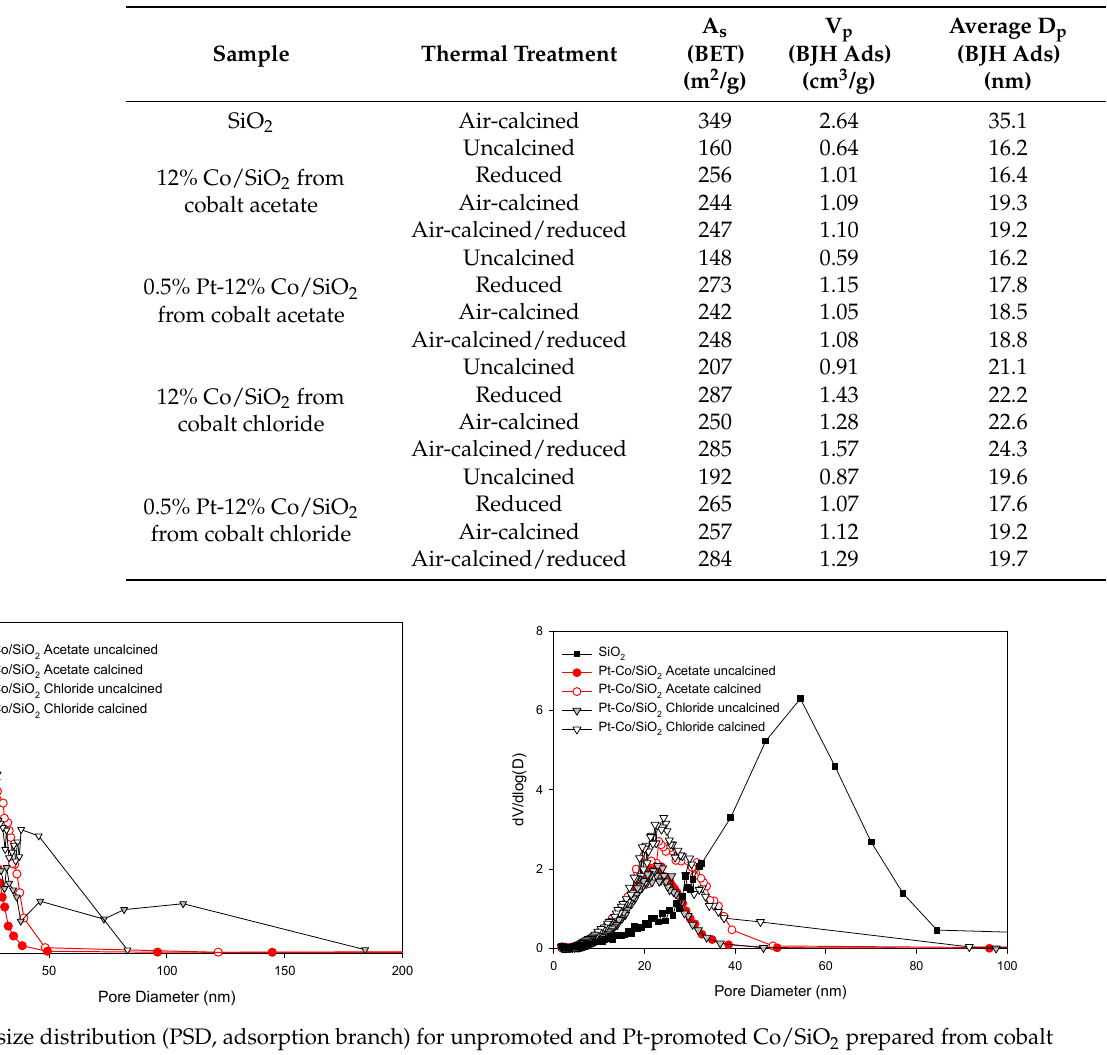
Table 1. BET surface area and BJH porosity measurement (N 2 adsorption branch).